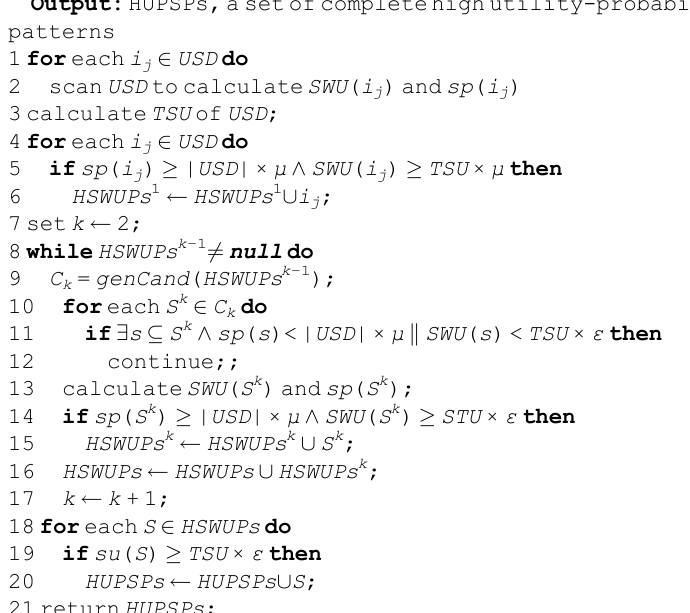
Algorithm 1 : Baseline U-HUSPM